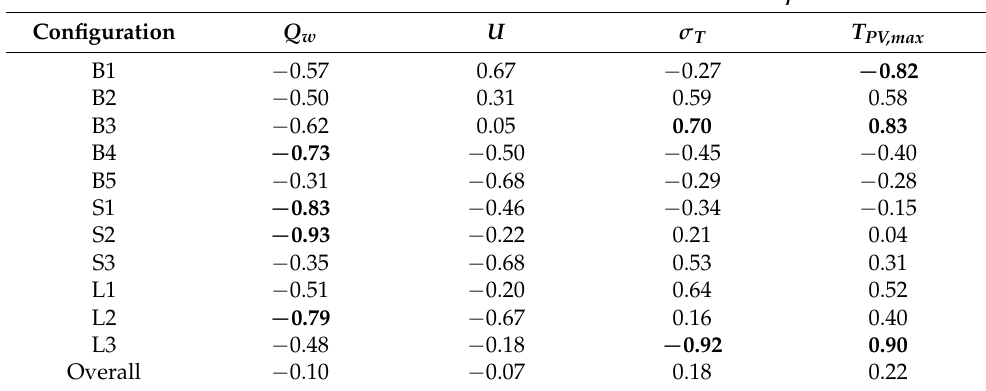
Table 4. Pearson correlation coefficients between efficiency drop ( ∆ η ) and each of the studied input parameters, for each configuration and for the overall data set. Highly significant correlation coefficients are highlighted in bold. Pearson Correlation Coefficient between ∆ η and: